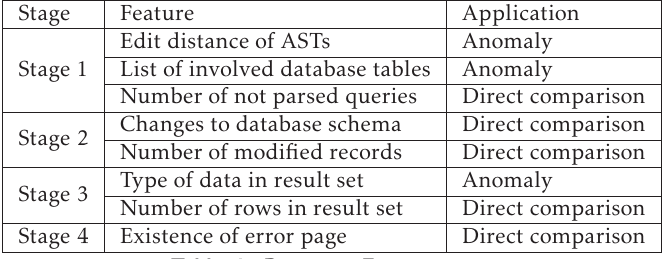
Table 4. Detection